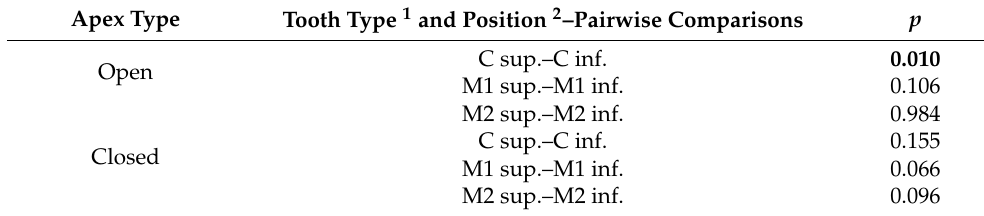
Table 4. Pairwise comparisons between superior and inferior primary teeth by tooth type.